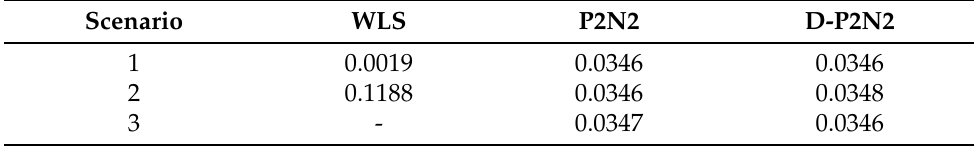
Table 1. The average estimation accuracy.